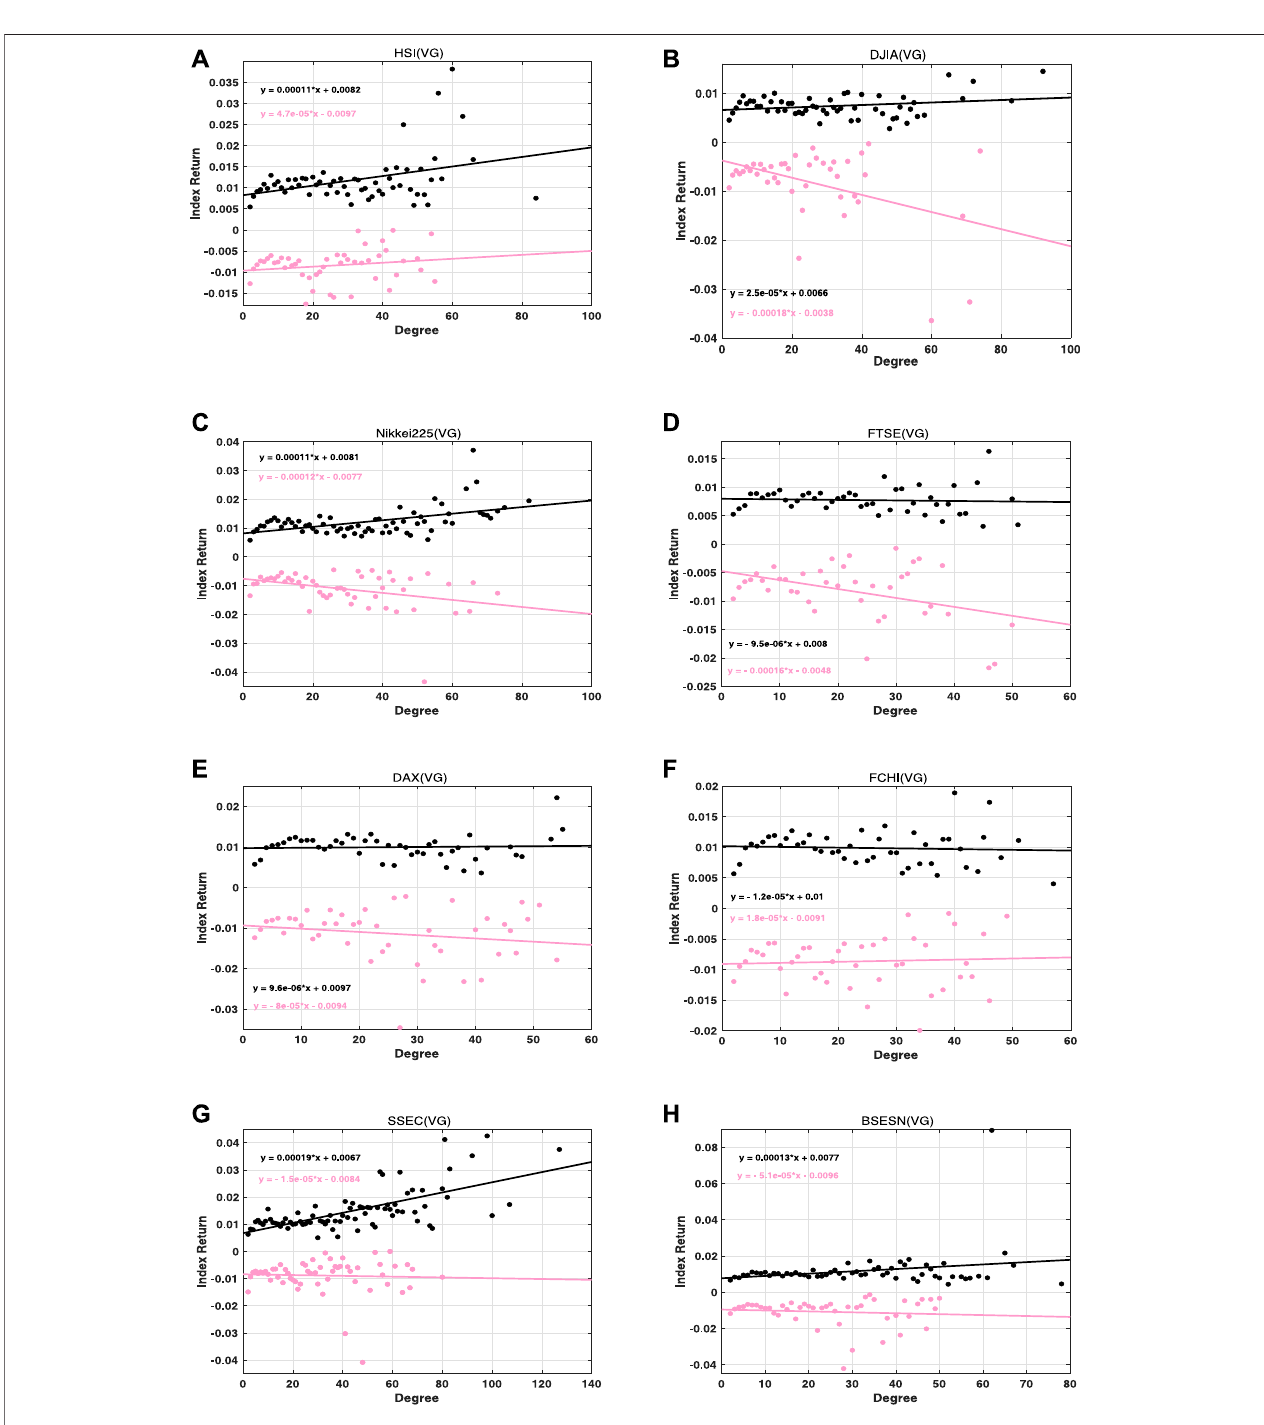
FIGURE10| ConditionalexpectedindexreturnsforthedegreeofriseandfallpricemotionswithinVGnetworksfortheeightstockindices.Redindicatesariseand black indicates a